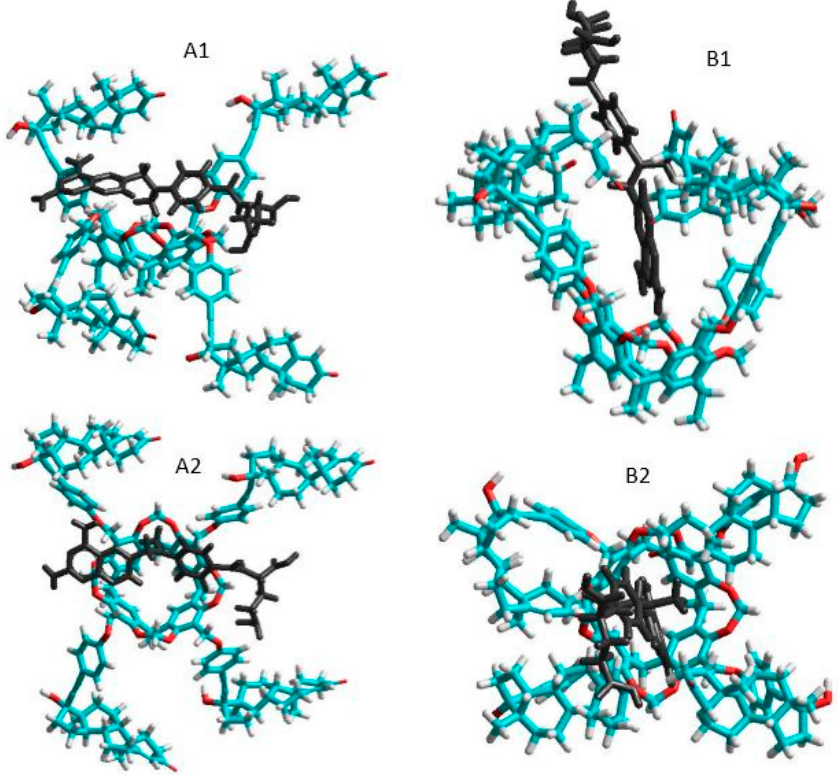
Figure 5. Side and top views of the equilibrium conformations of methotrexate–cavitand complexes associated with the opened ( A1 and A2 ) and closed ( B1 and B2 ) conformations of the cavitand (blue, red, white and black colors mean carbon, oxygen, hydrogen atoms and MTX molecule, respectively).